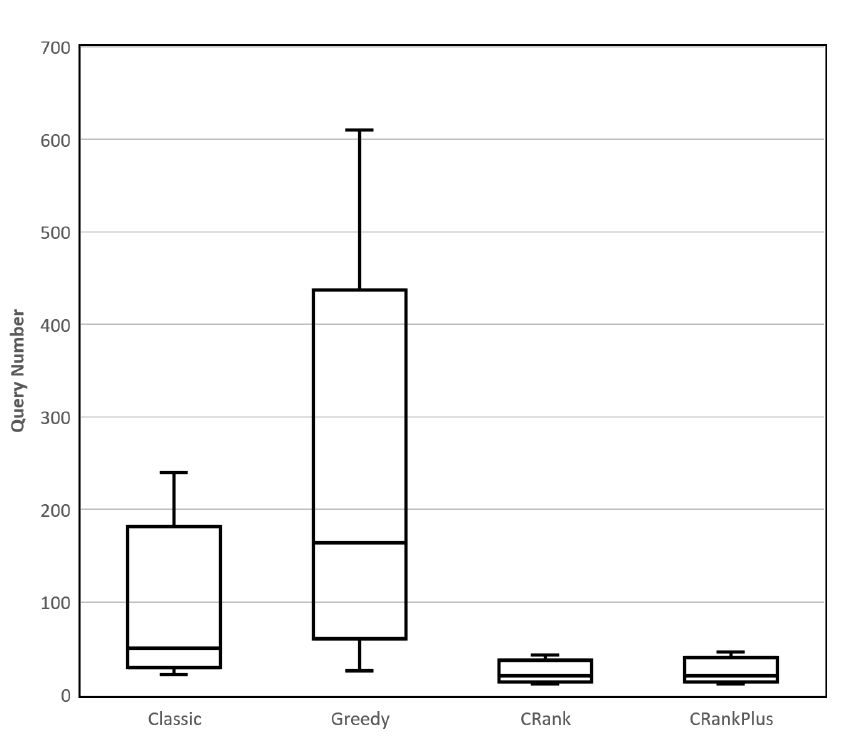
Figure 2. Query number distribution of classic, greedy, CRank, and CRankPlus. Table 8. Average results. “QN” is query number. “CC” is computational